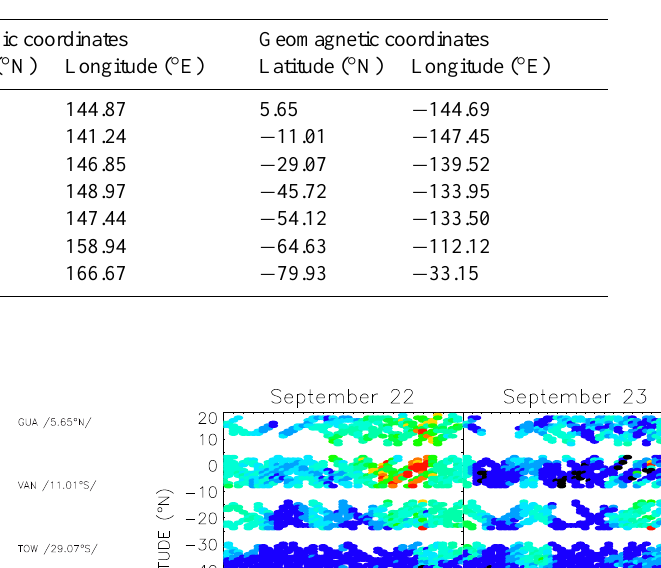
Table 1. Geographic and geomagnetic coordinates of the chain of IGS stations that provided data for this study. The three letters in bracket refer to the abbreviation of the station names.